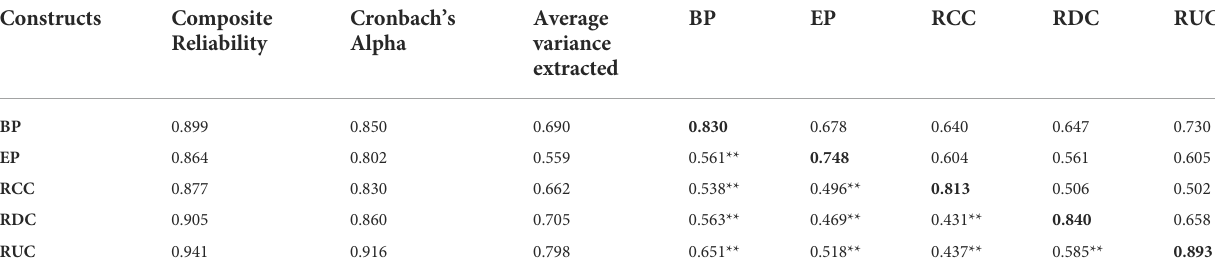
TABLE 3 Construct consistency, reliability, convergent and discriminant validity squared value of the AVE reported on the main diagonal of the correlation matrix.